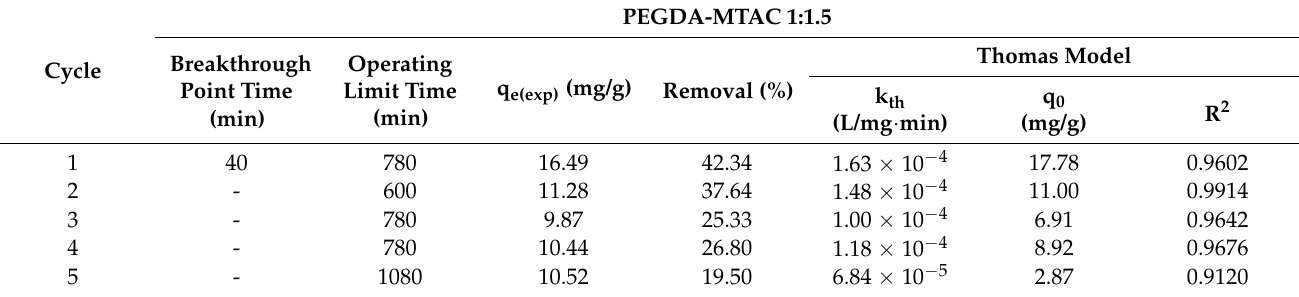
Table 8. Thomas model parameters linear regression analysis for